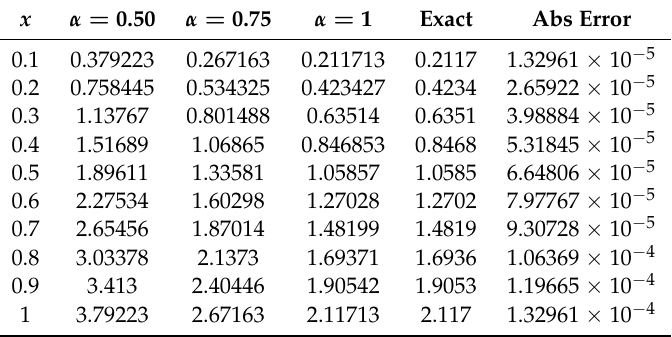
Table 14. Third order approximate results for different values of α at t = 0.75 of Example